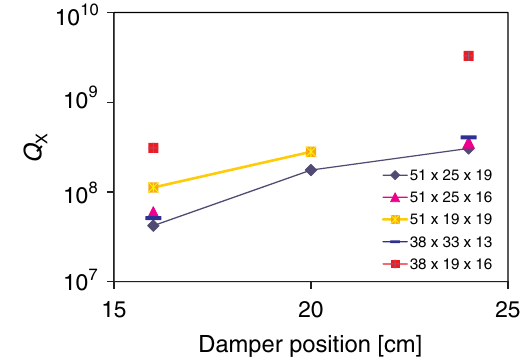
FIG. 22. Q external of fundamental versus damper position and probe size (disk diameter (cid:2) stem length (cid:2) stem diameter in mm), probe position is defined in Fig. 19.